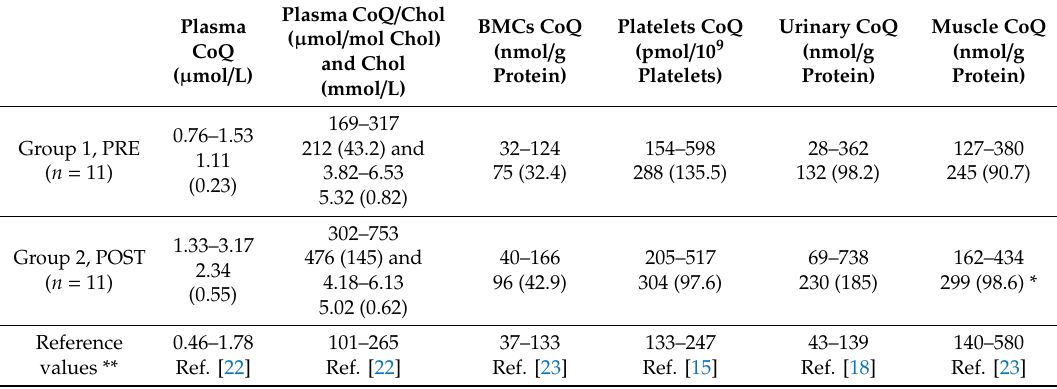
Table 1. Biochemical results of subjects before (group 1, PRE) and after (group 2, POST) coenzyme Q 10 (CoQ) supplementation. Data are expressed as range, average, and standard deviation, together with previously reported reference values in the